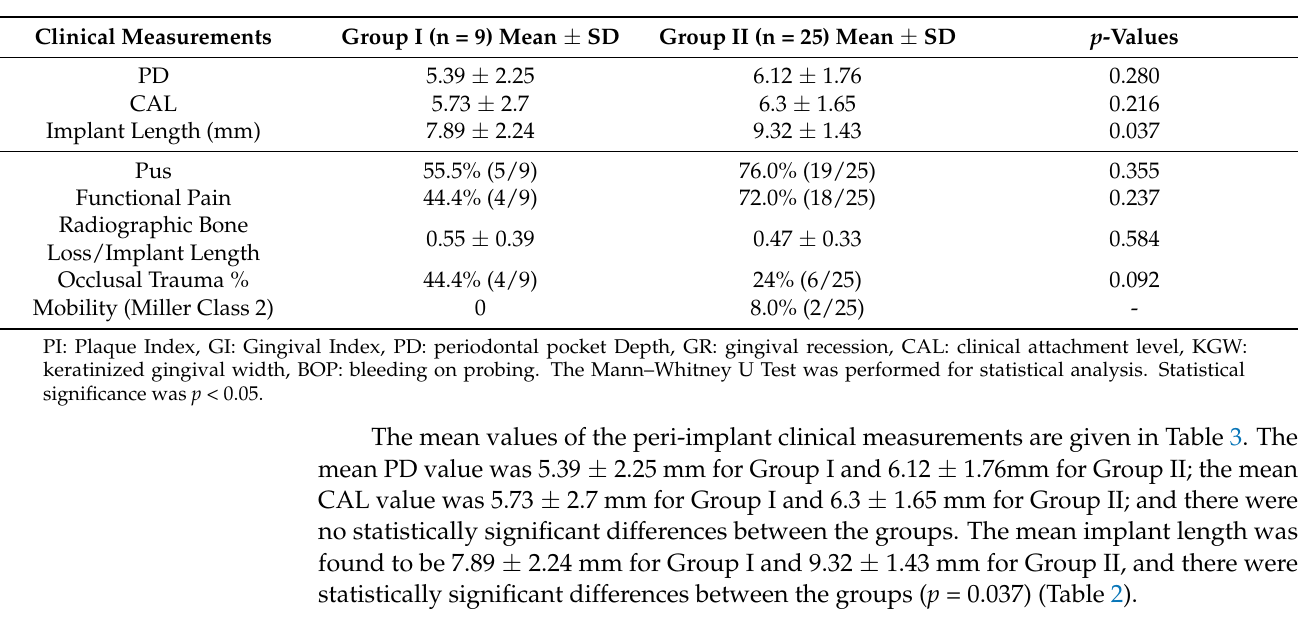
Table 3. The comparative chemical surface analysis of different regions of dental implant surfaces as atomic weight % between the groups and